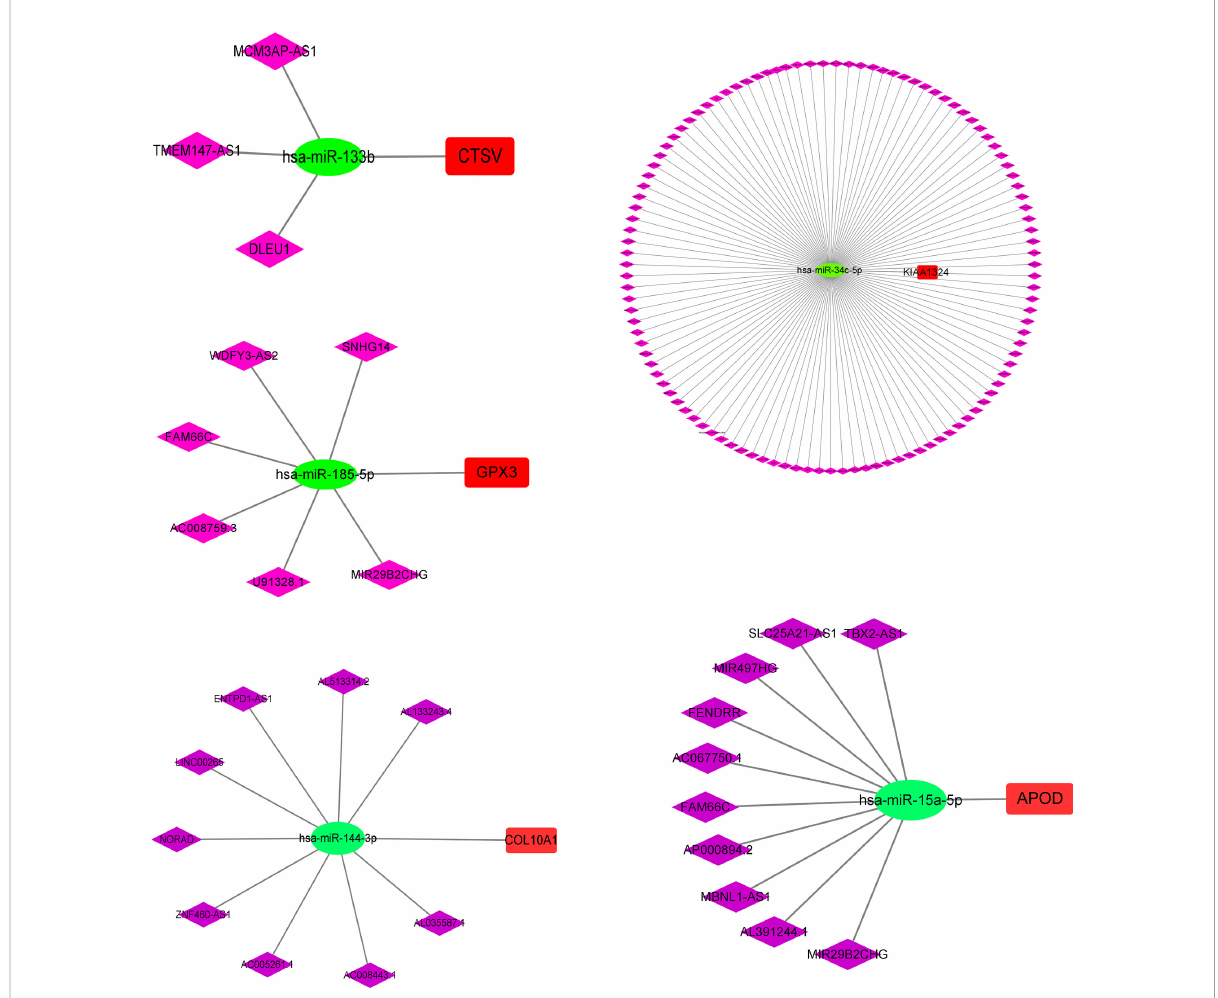
FIGURE 11 CeRNA Regulatory Network Analysis of fi ve risk genes. CeRNA, competing endogenous